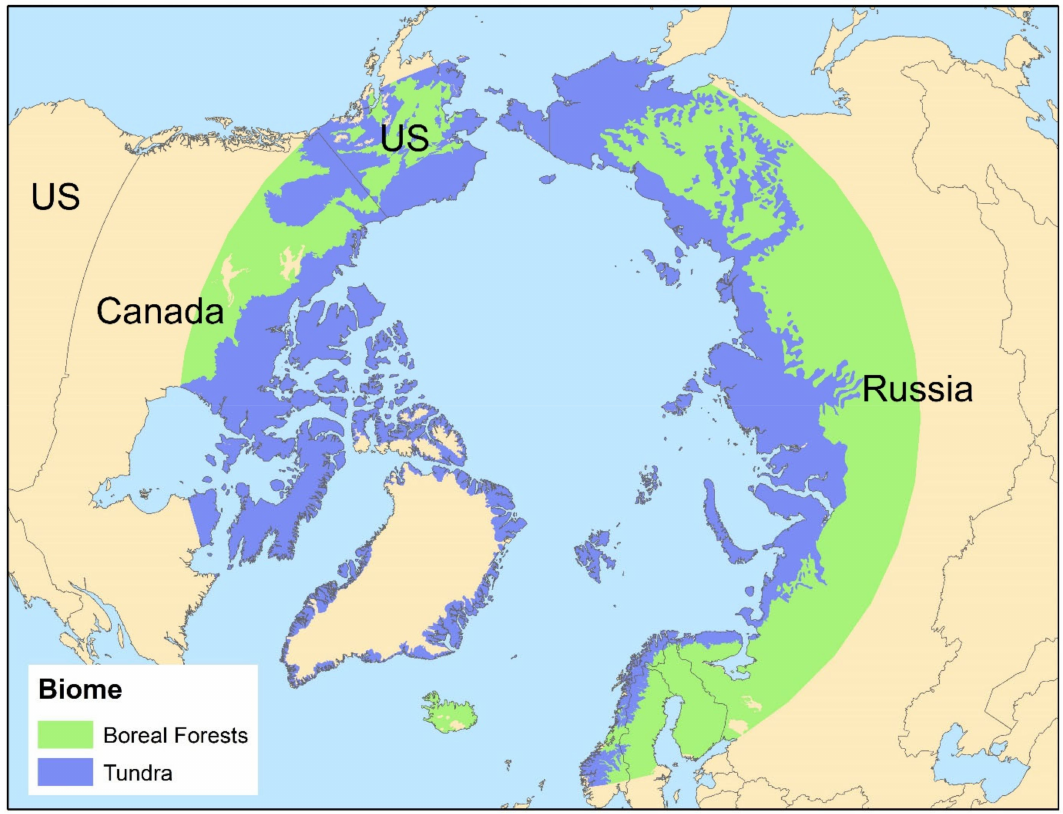
Figure 1. The extent of the study area, as represented by areas in green (the boreal forests) and purple (tundra). The delineation of the boreal forest and tundra biomes is based on the World Wildlife Fund (WWF) Terrestrial Ecoregions dataset